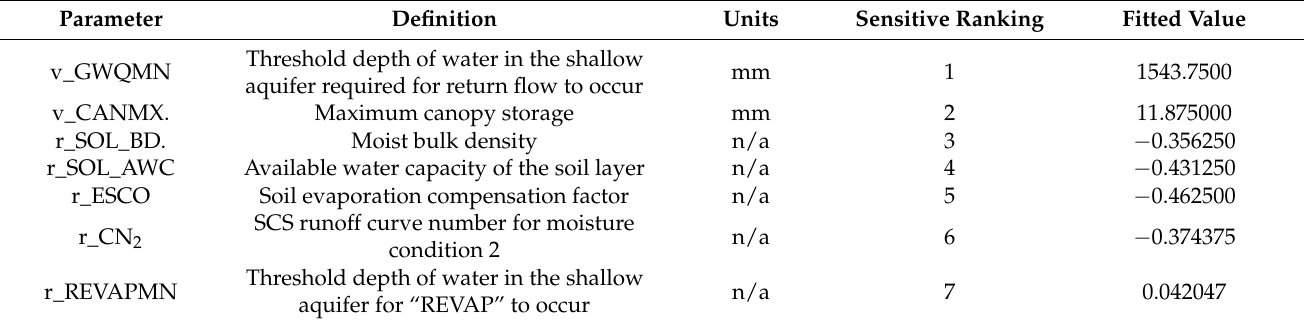
Figure 3. Monthly hydrographs for the calibration period (1981–1985) and the variation period (1986–1989) at Qingshui station. Table 1. Summary of calibration parameters implemented with SUFI2.